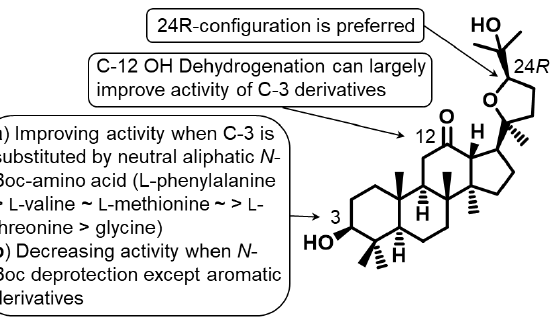
Figure 3. Preliminary structure–activity relationships of 12-dehydropyxinol derivatives.